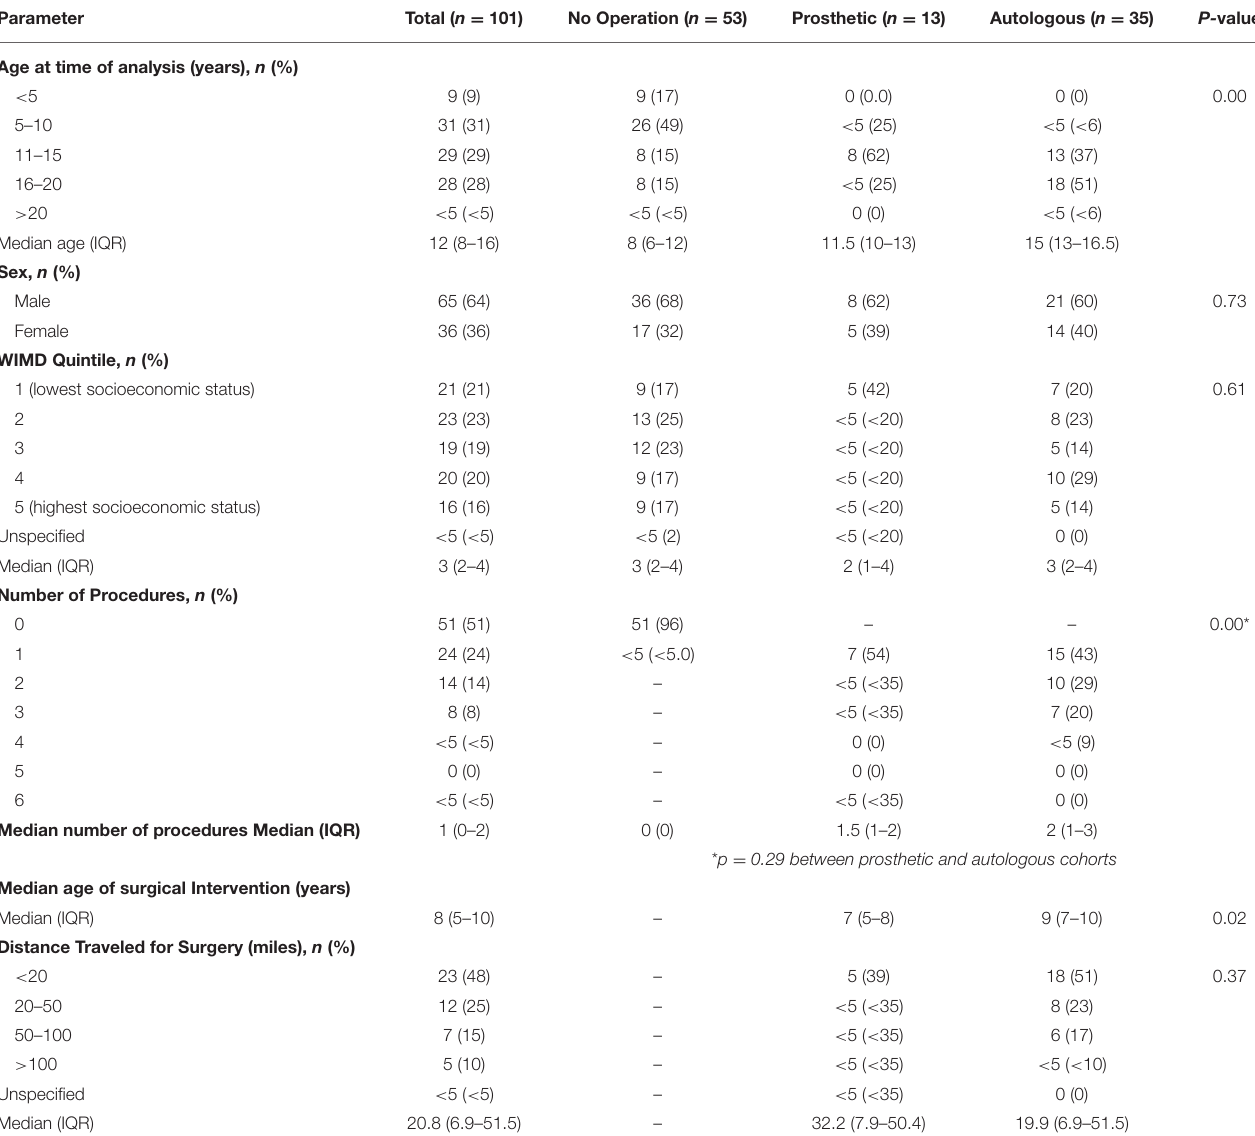
TABLE 2 | Patient Demographics assessed at the time of analysis (April